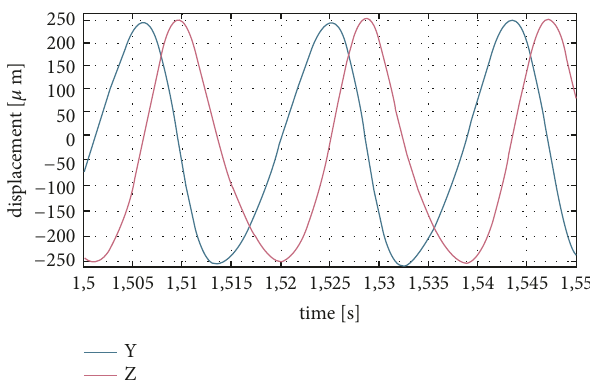
Figure 29: Time zoom of the predicted rotor vertical (in blue) and horizontal (in red) displacements at DE node during a combined landing test.